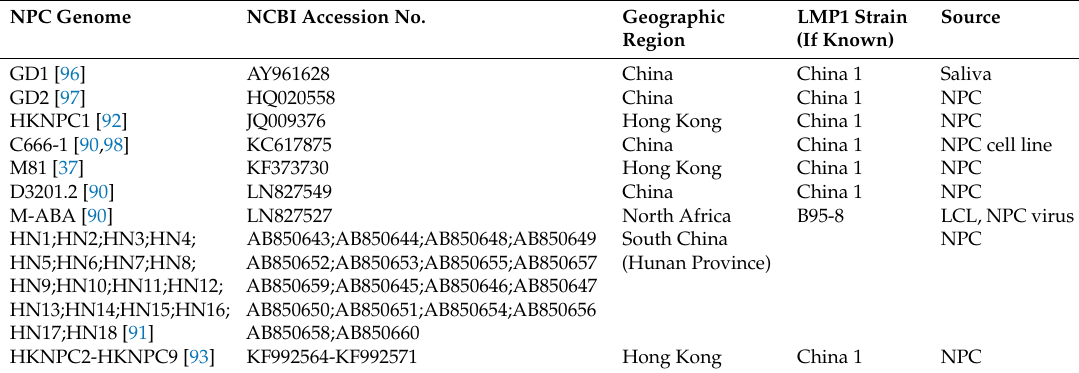
Table 1. Epstein-Barr virus (EBV) genomes sequenced from nasopharyngeal carcinoma (NPC) patient specimens. NPC